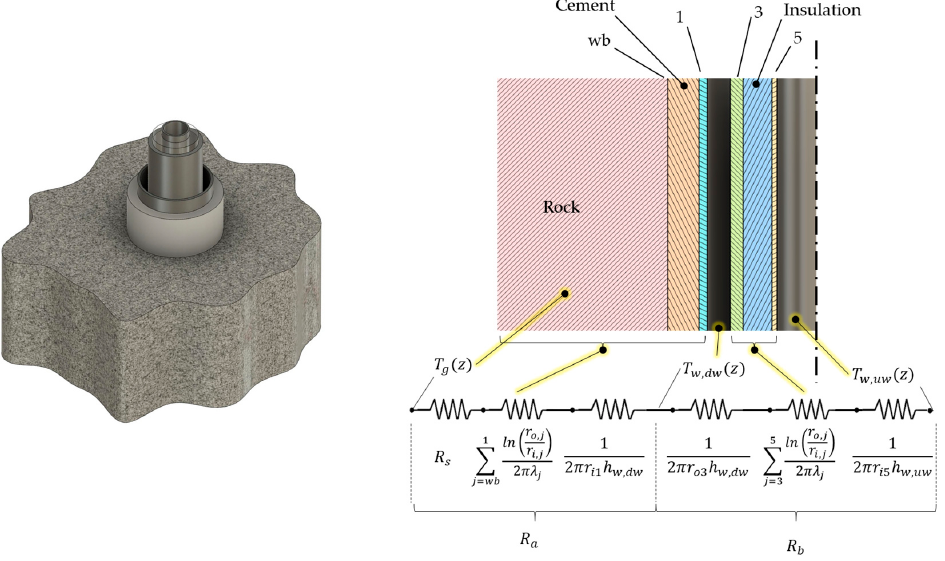
Figure 1. Thermal resistances and cross-section of the DBHE. wb—wellbore diameter, 1—external casing, 3—external tube of the VIT, 5—internal tube of the VIT.